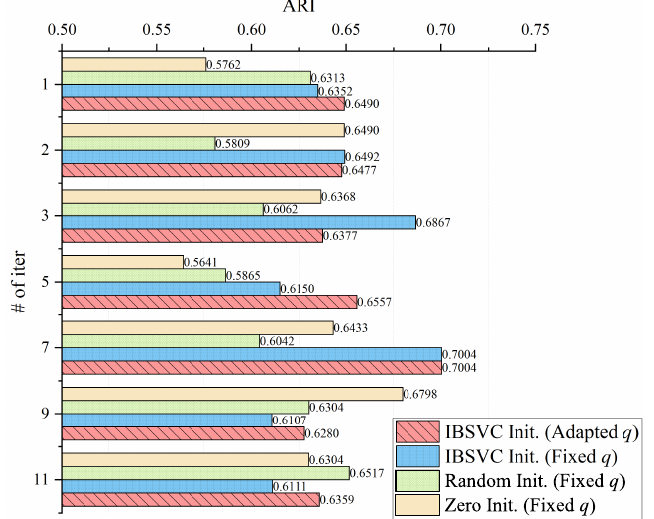
Figure 5. Accuracies of different β initial strategies and # of